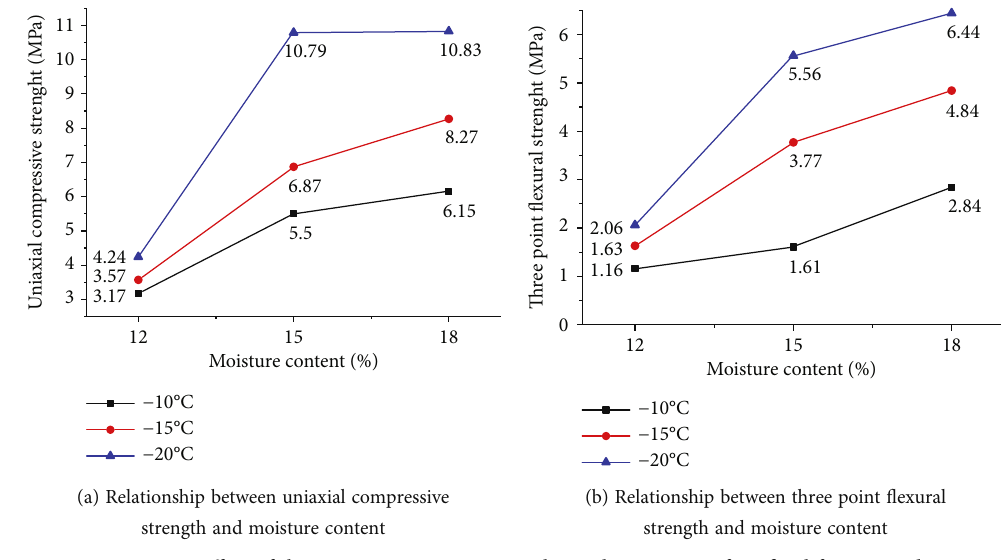
Figure 3: E ff ect of the moisture content on mechanical properties of arti fi cial frozen sand. Table 2: Percentage increase of mechanical properties of arti fi cial frozen soil with di ff erent moisture contents. Curing temperature ( °